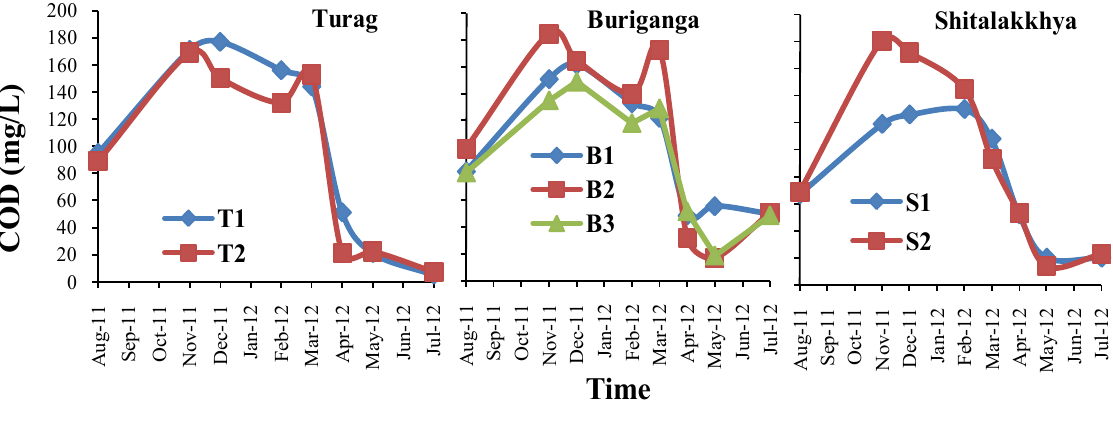
Figure 9. The chemical oxygen demand (BOD) values of the samples from the water of three different rivers around Dhaka